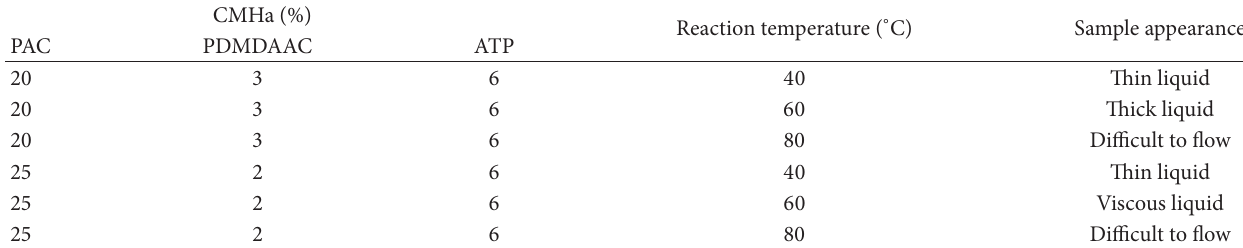
Table 5: The influence of reaction temperature on the appearance viscosity of produced samples.